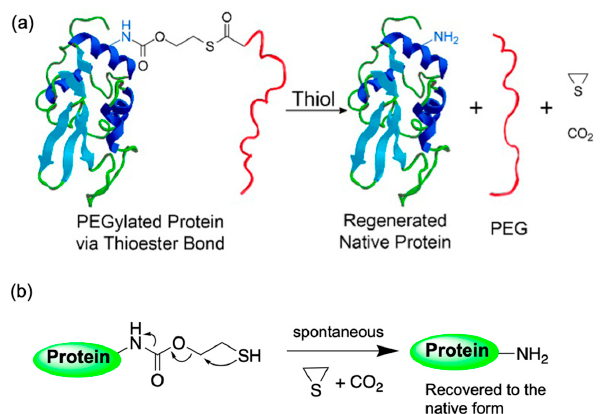
Figure 4. Example of glutathione/reductive environment-sensitive traceless PEG detachment. ( a ) Schematic representation of thioester-mediated, traceless, reversible PEGylation of protein. ( b ) Chemistry involved in protein regeneration after PEG detachment via thioester-cleavage-generated thiol group triggers an intramolecular reaction to generate a three-membered thiirane and CO 2 , rescuing the protein in its native form. Reprinted with permission from [74]. Copyright ACS 2013.